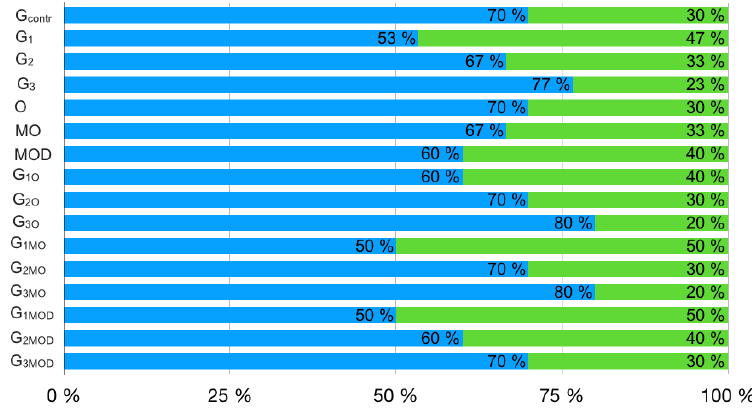
Figure 4. Percentage incidence of favorable (blue) and unfavorable (green) fractures.